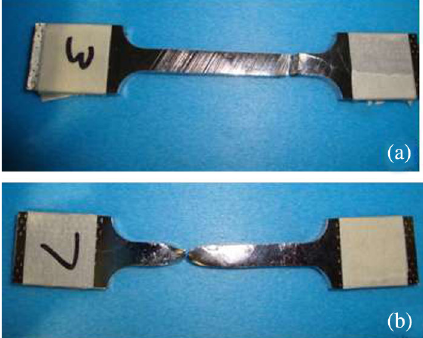
FIG. 26. Images of sample No. 3 (a) and No. 7 (b) after tensile test at 77